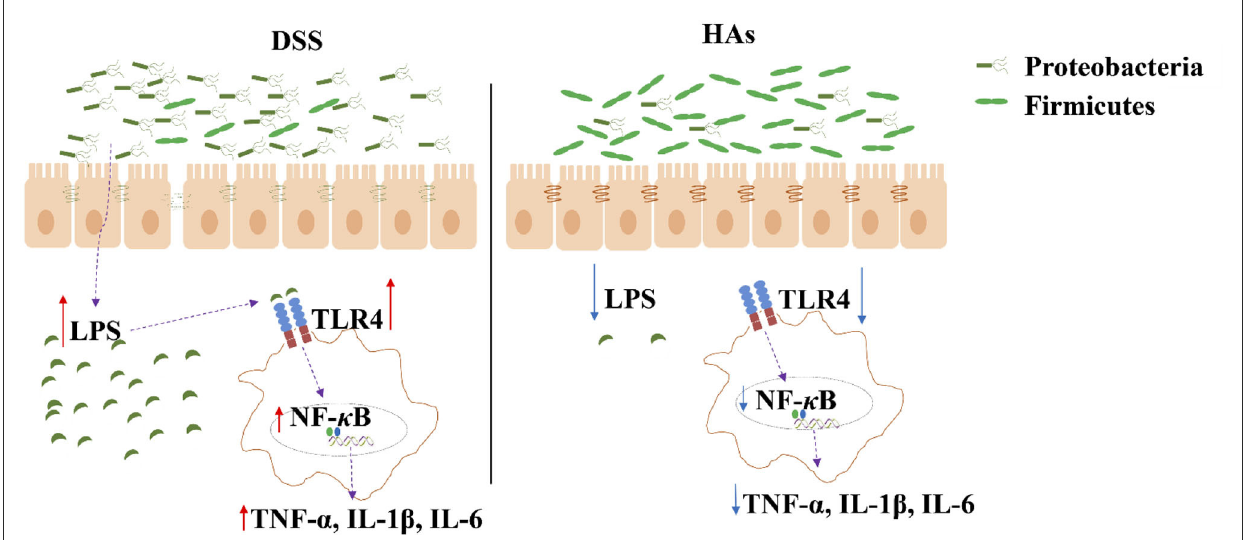
FIGURE5 Illustration of the mechanism by which HAs reduce inflammation. HAs decrease the abundance of Proteobacteria but increase that of Firmicutes . The reduced level of Proteobacteria decreases LPS concentration, which further inactivates the expression of TLR4 and the production of inflammatory cytokines (TNF- α , IL-1 β , and